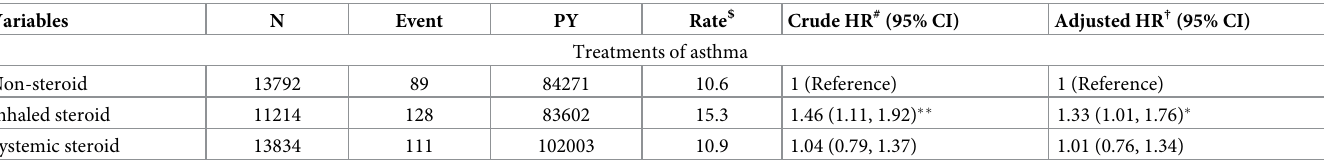
Rate $ per 10000 person-year; Crude HR#, relative hazard ratio; † Model was adjusted for age, sex, and comorbidities of hypertension, diabetes, hyperlipidemia, COPD, CAD, stroke, rhinitis, chronic sinusitis, GERD and obesity; ‡ Patients with any comorbidity of hypertension, diabetes, hyperlipidemia, COPD, CAD, stroke, rhinitis, chronic sinusitis, GERD, and obesity was defined as the comorbidity group; � p < 0.05,